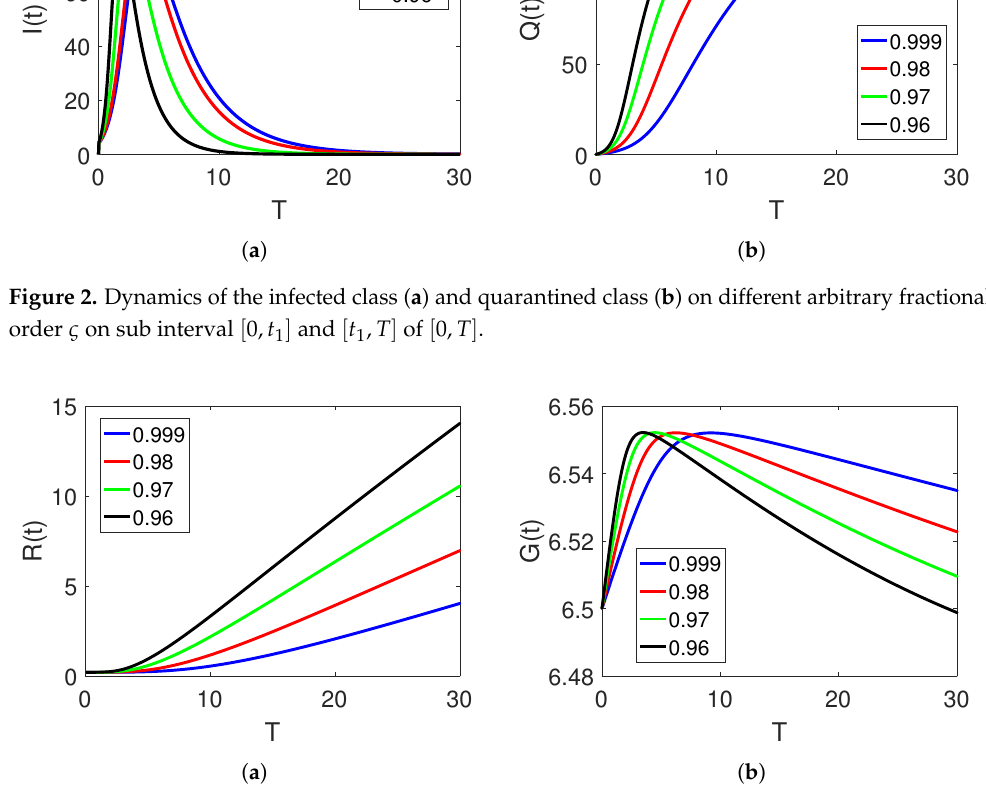
Figure 3. Dynamical behavior of the recovered class ( a ) and isolated class ( b ) on different arbitrary fractional order ς on sub interval [ 0, t 1 ] and [ t 1 , T ] of [ 0, T ] .